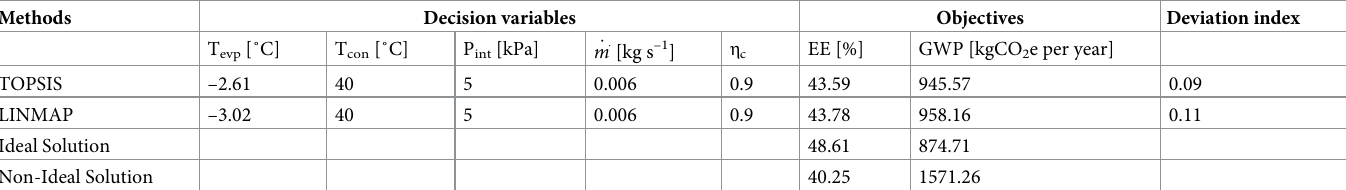
Table 7. Optimal solutions obtained via decision-making methods for the third scenario.